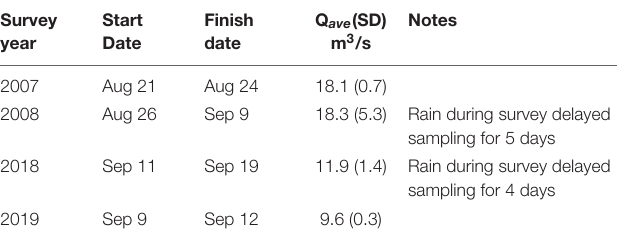
TABLE 1 | Start and finish dates and average (SD) daily discharge of the Elwha River during the four riverscape surveys. Discharge data (Q ave in m 3 /s) from USGS Elwha River at McDonald Bridge near Port Angeles, WA, United States (USGS,